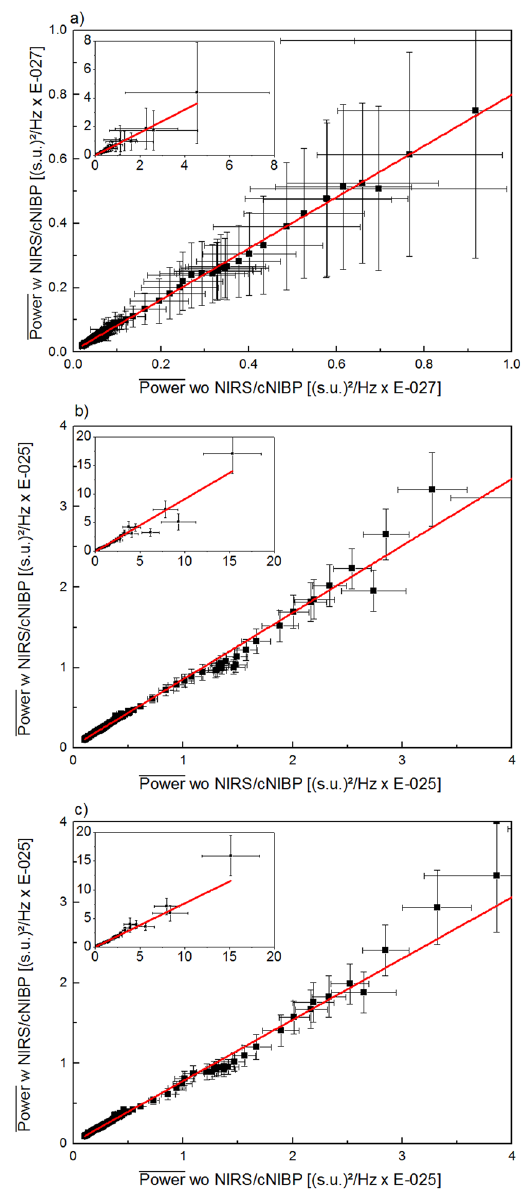
Figure 4. Comparison of mean power values (black dots, whiskers = SD) measured with magnetometers ( a ) and planar gradiometers ( b and c ), with (x axis) and without (y axis) the multimodal setup. For better visualisation the plots show an extract of all data, which were shown in each inset separately. In all cases the data can be well explained by a linear fit (red line). Note the slight positive intercept of the linear fits due to smaller power values when the multimodal setup is applied. The external sensors for NIRS are attached on back of the head and on forehead above left eye. Sensors for cNIBP are attached on chest and neck (see Figure